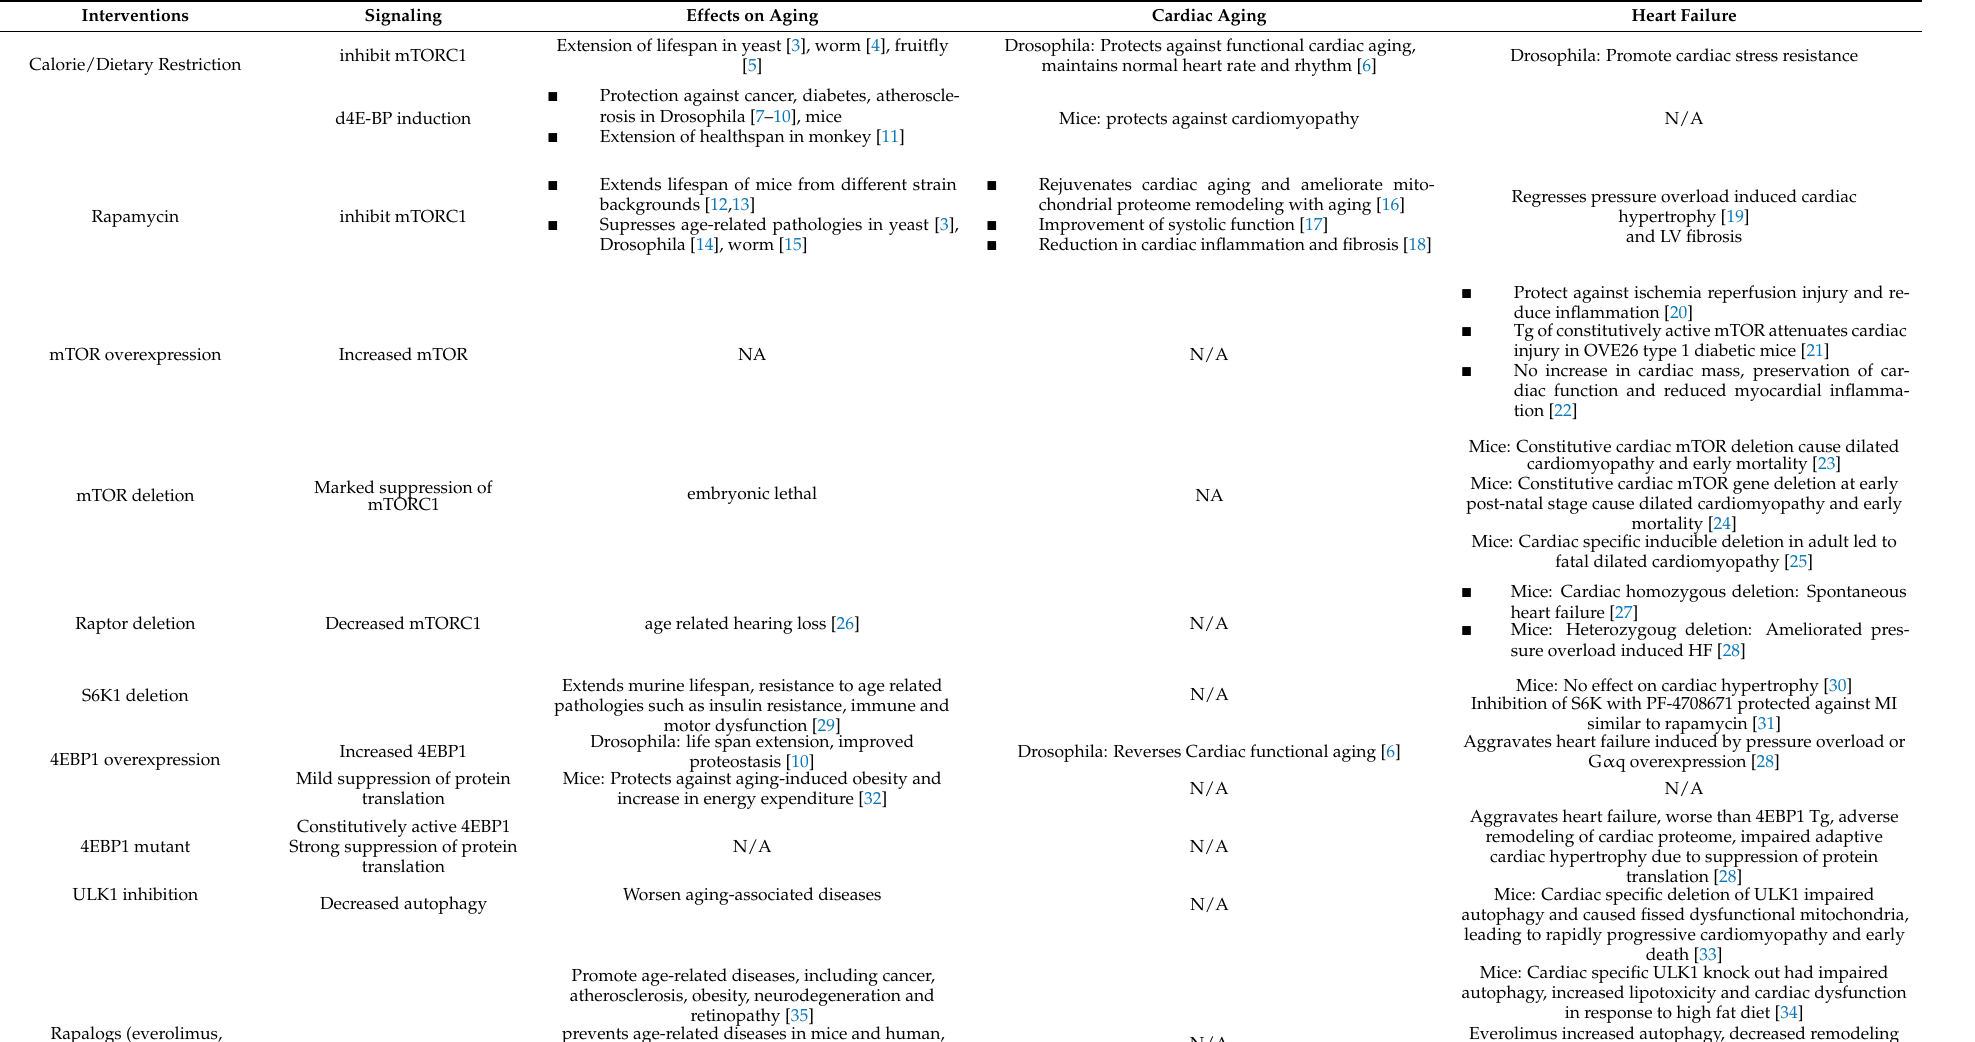
Table 1. Role of mTOR Signaling in Aging and Heart Failure